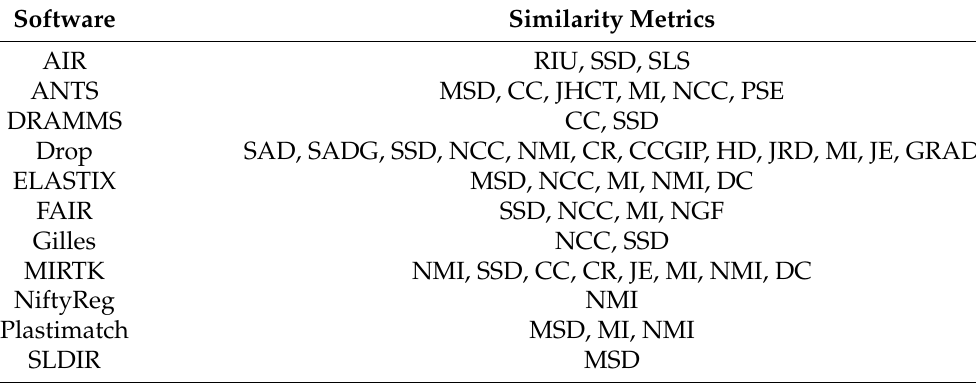
Table 2. Similarity metrics used by different registration software.